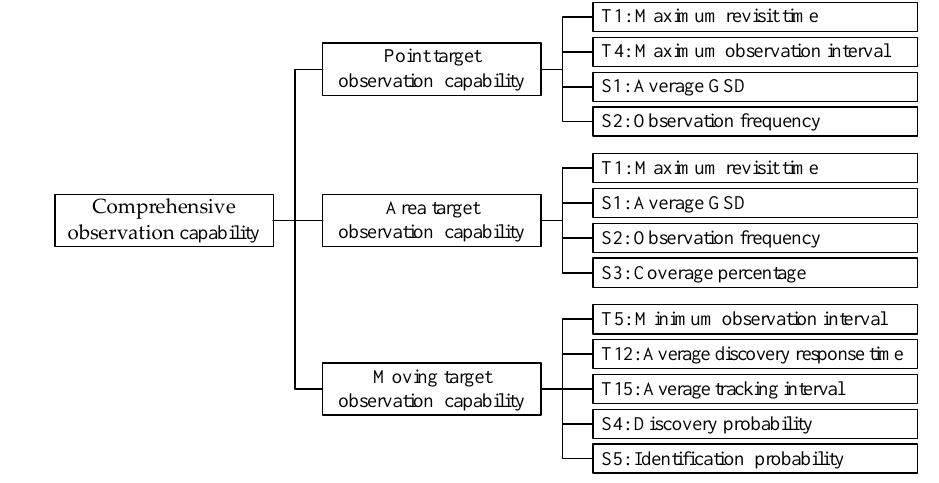
Figure 14. Evaluation index system for remote sensing satellites.